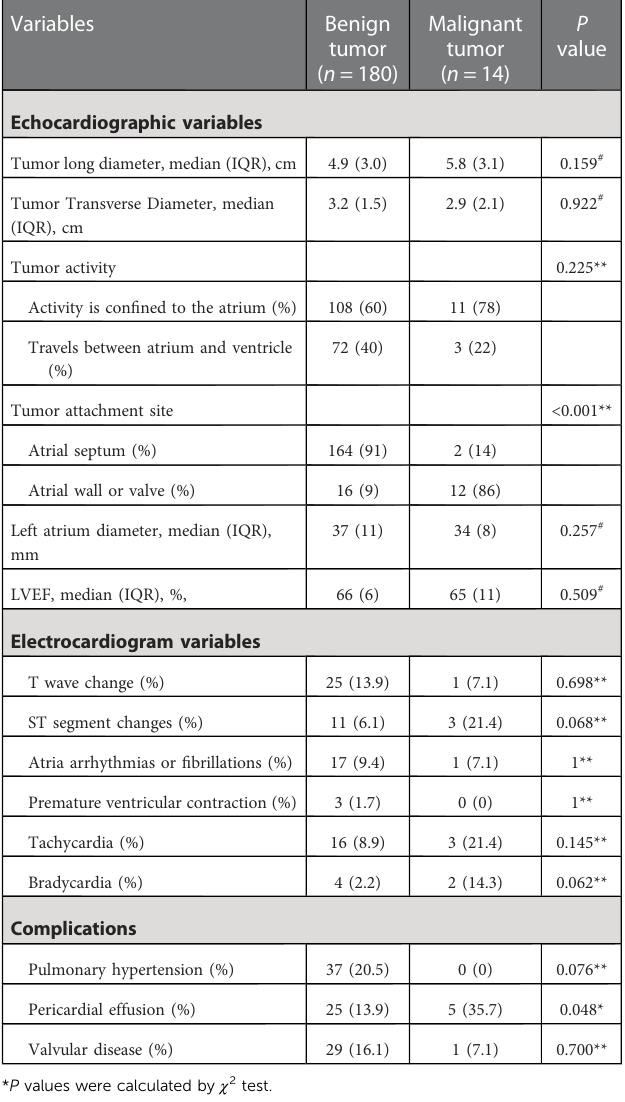
TABLE 2 The blood routine characteristics of patients with primary atrial tumor.